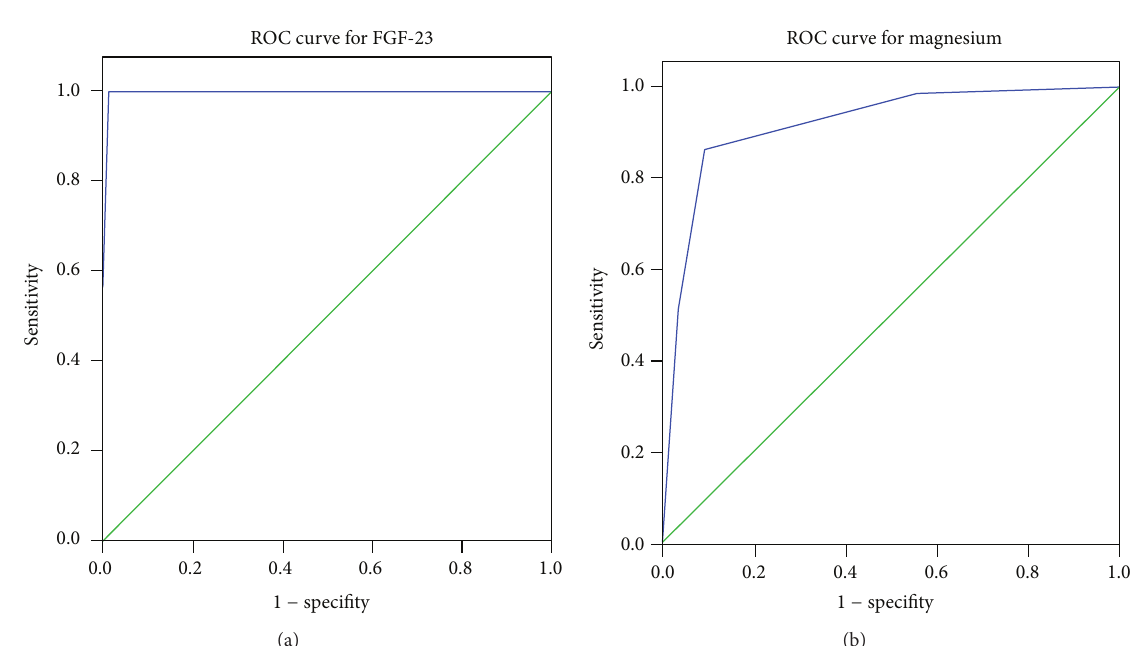
Figure 5: ROC curve analysis results for serum levels of FGF-23 (a) and magnesium